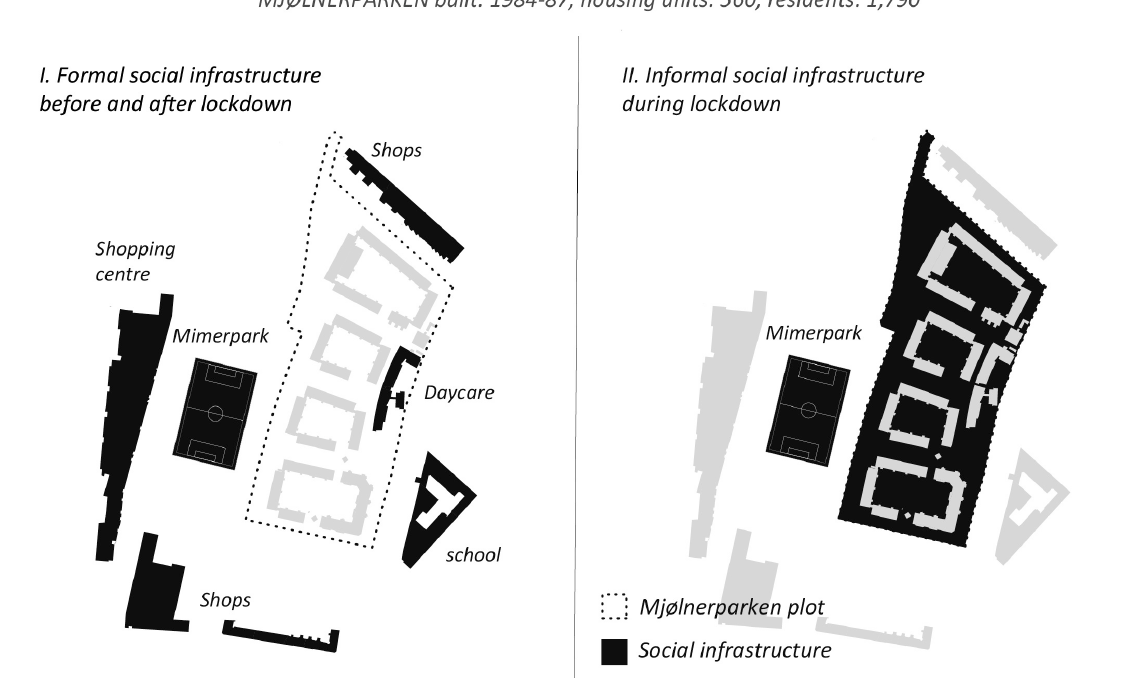
Figure 5. Social infrastructure before/after (I) and during the lockdown (II) in